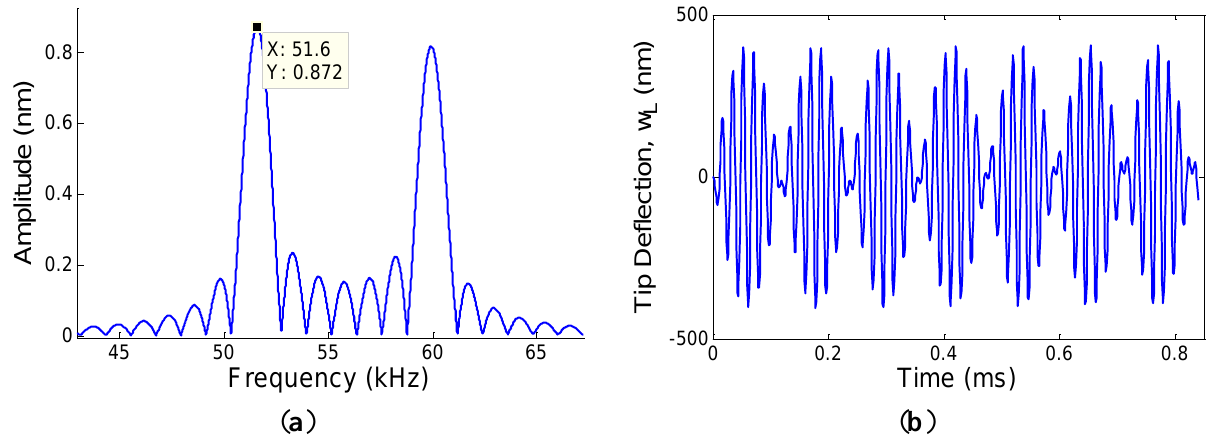
Figure 7. ( a ) Tip deflection of MC, w natural frequency